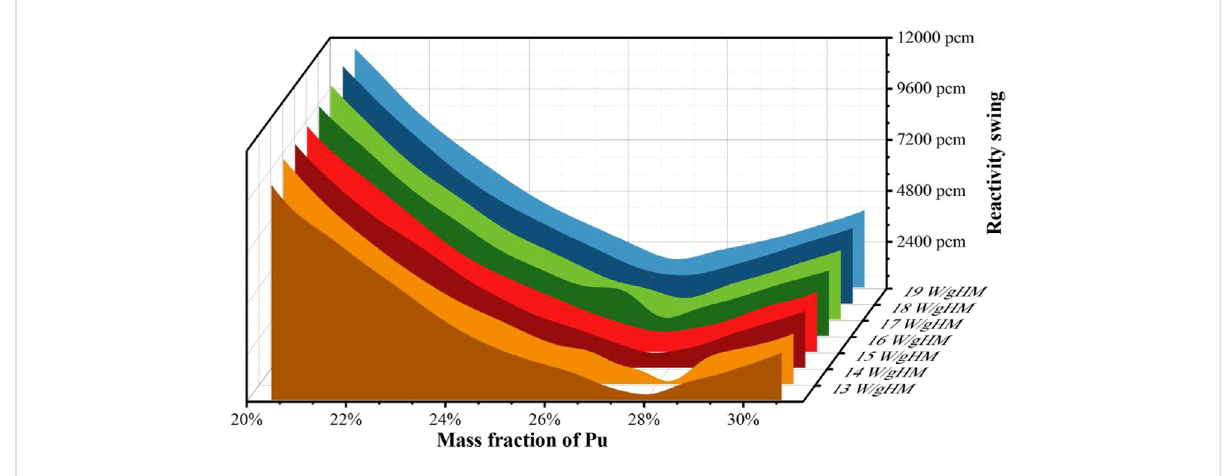
FIGURE 4 Plot of reactivity swing, speci fi c power, and mass fraction.